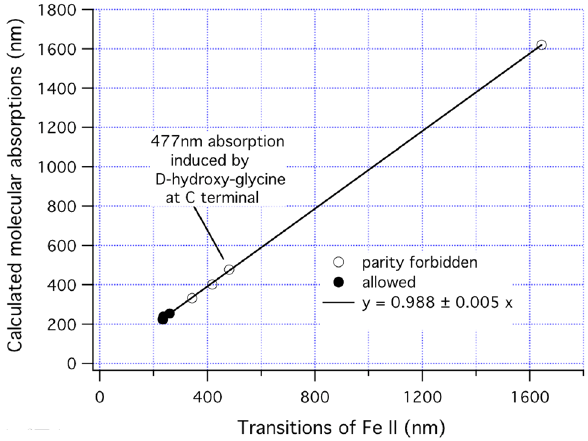
Figure 3. Correlation between transitions in Fe II (Fe + ) and RPA calculated transitions for molecular cases with R(D) chirality hydroxy-glycine in C-terminal contact with Fe.